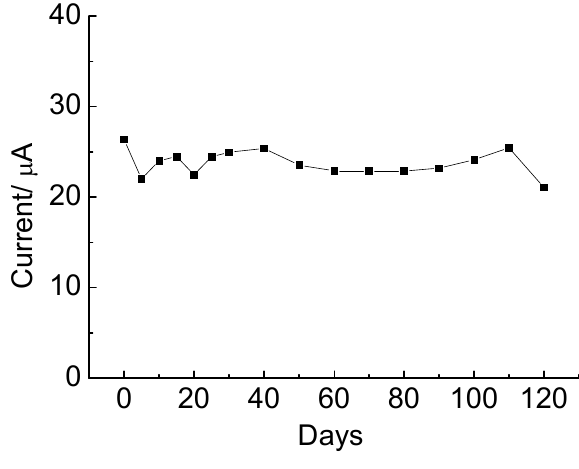
Figure 7. Storage stability profile of genosensor at 8 °C. The biosensors were stored in refrigerators when not in